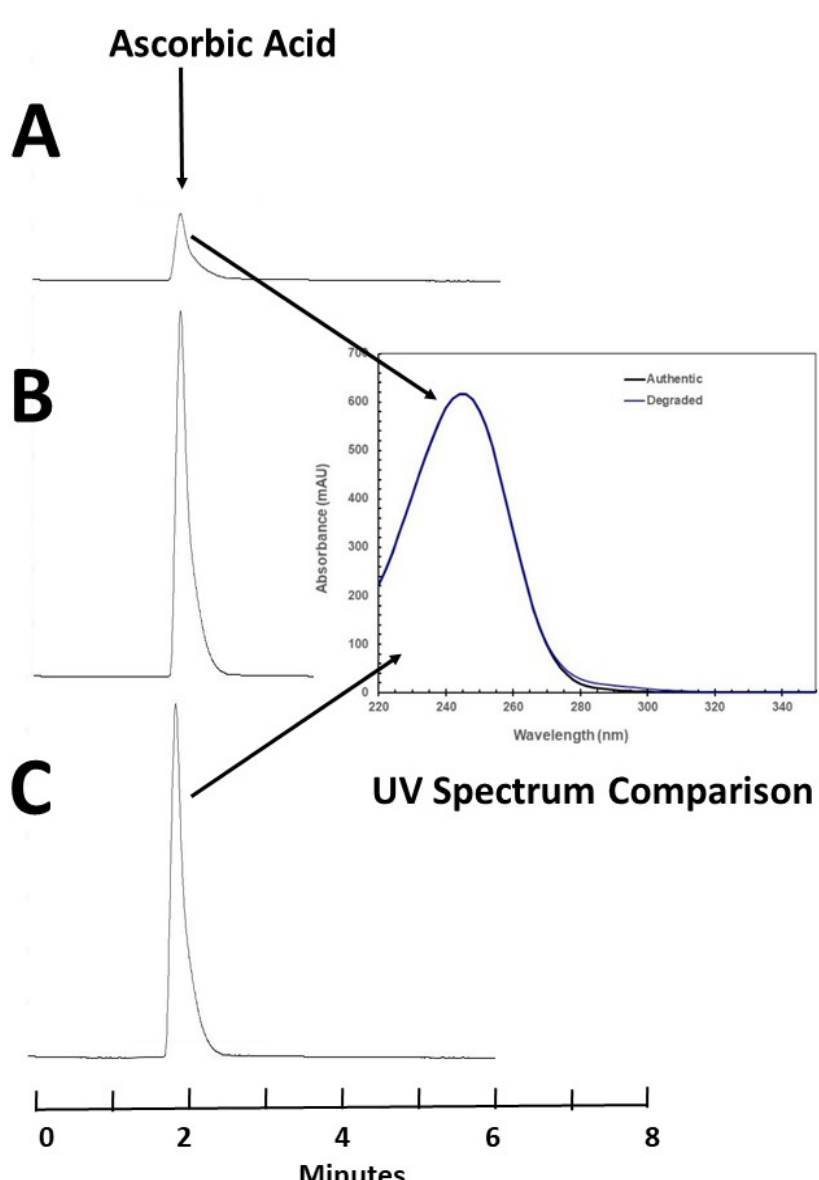
Figure 1. Chromatogram A represents an 80 mg / mL solution of ascorbic acid (AA) after the addition of sodium hypochlorite, which resulted in degradation of AA, leaving 13.8% of the initial concentration. No degradation products are observed. To confirm specificity, meaning the ‘purity’ of the AA peak, the UV spectrum was compared to the UV spectra observed in a fresh authentic (undegraded) AA peak (overlayed spectra, similarity 99.97%). Chromatogram C represents a 77 mg / mL solution in normal saline (NS) on study day zero. Chromatogram B represents the same 77 mg / mL solution in NS after 10 days storage at room temperature. The observed percentage remaining was 93.36%.